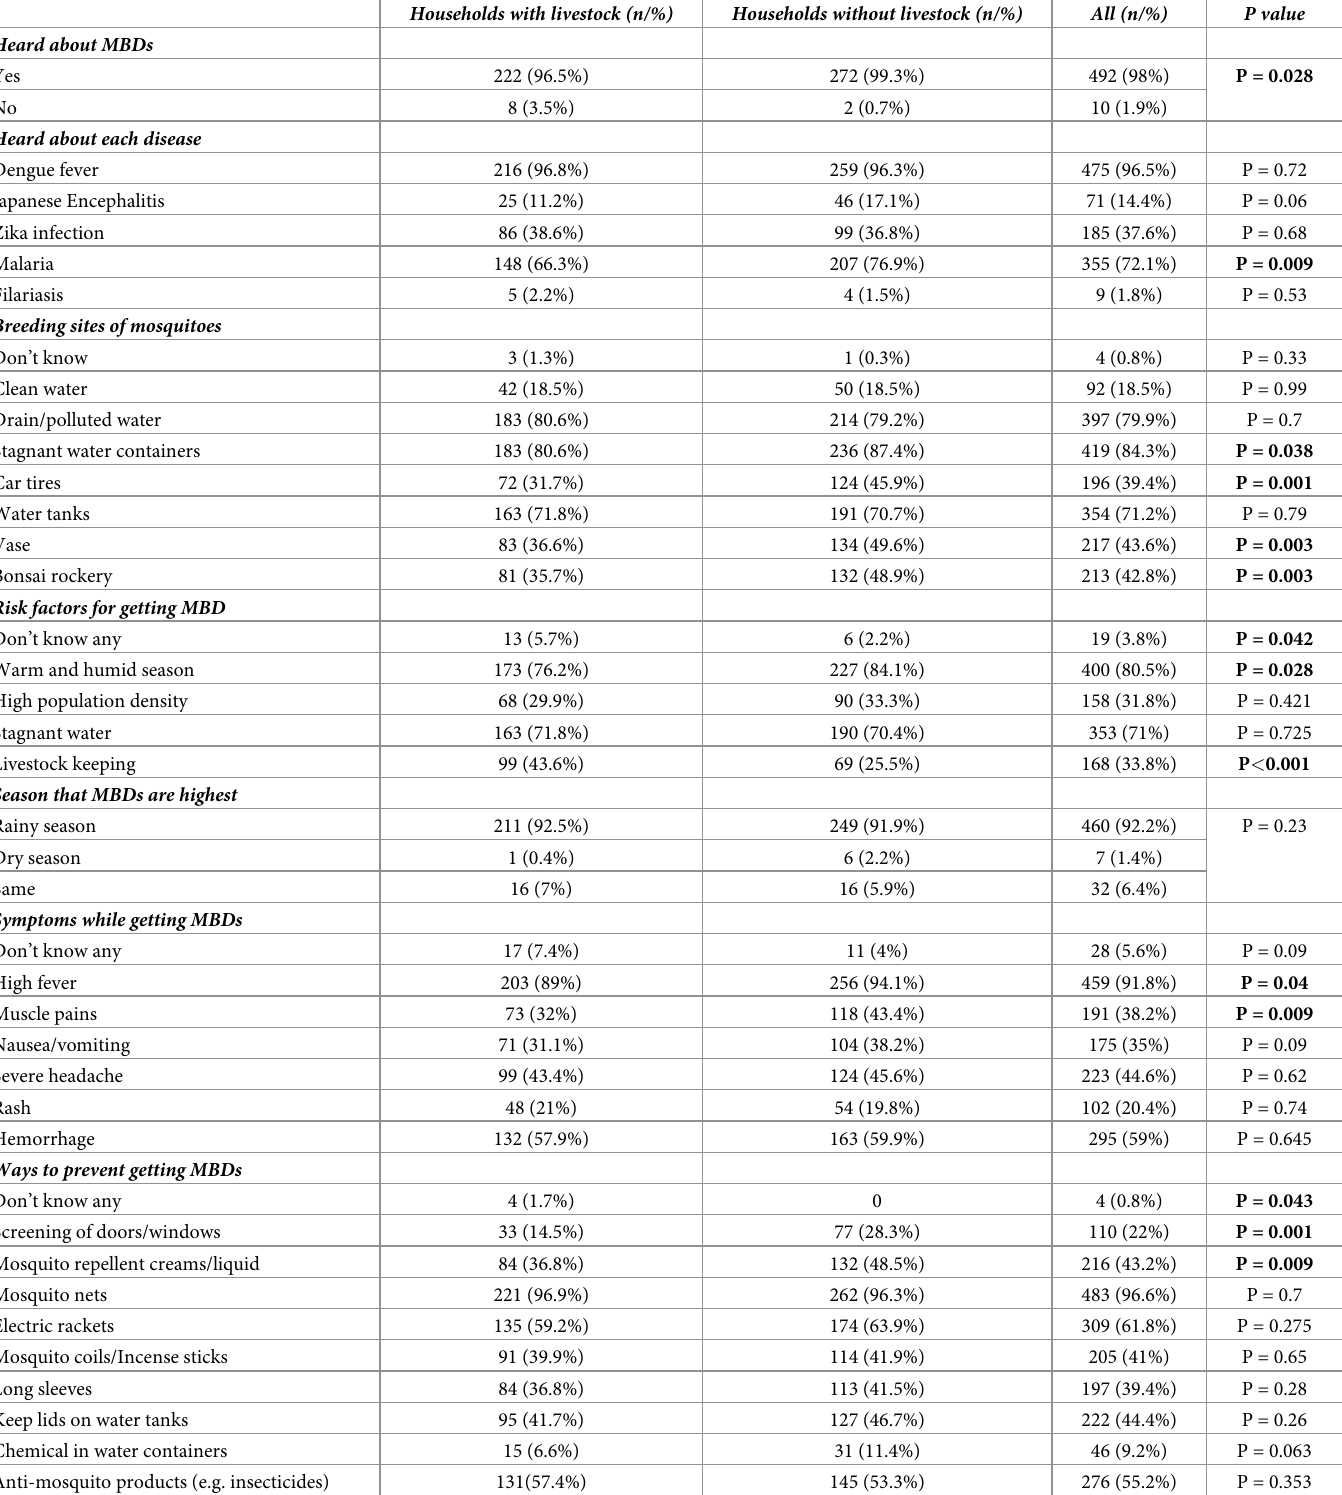
Table 2. Knowledge about mosquitoes and mosquito-borne diseases in households with and without livestock in Hanoi, Vietnam. Households with livestock